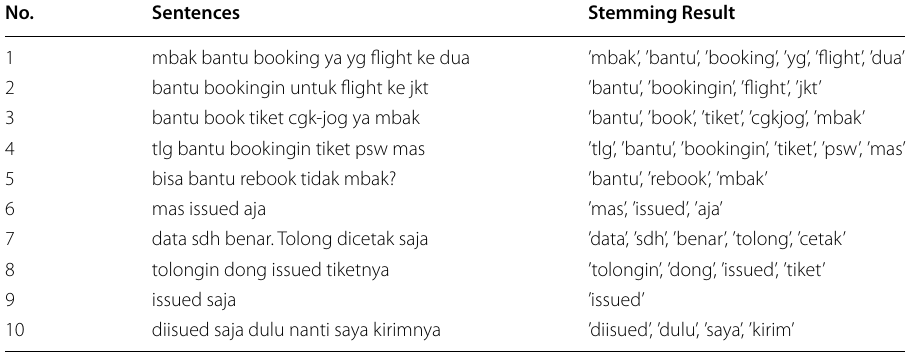
Table 3 The result of stemming by using “Sastrawi”